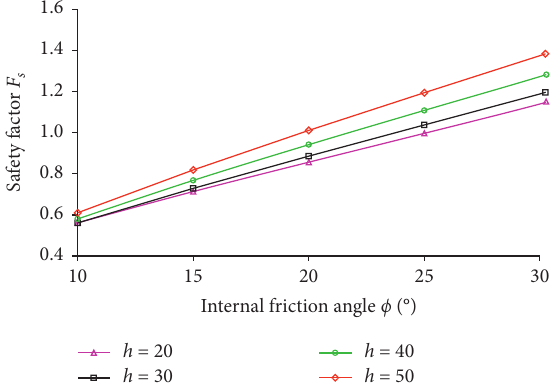
Figure 7: Relationship between the safety factor and internal friction angle of the weak